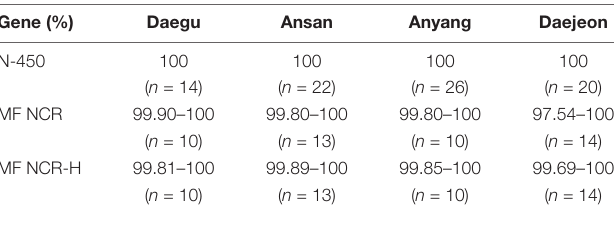
TABLE 2 | Comparison of the similarity of the identified measles genes in South Korea from December 2018 to May